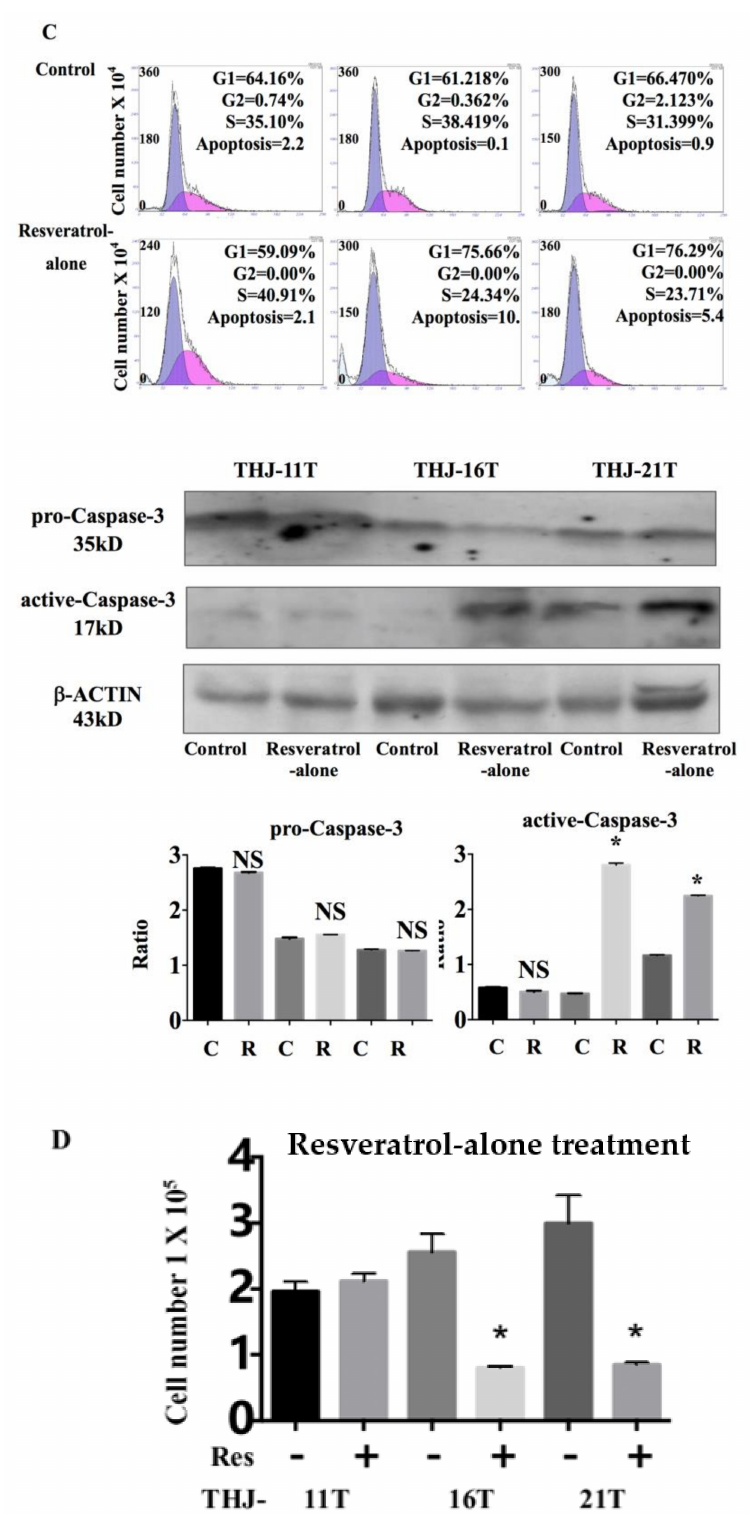
Figure 2. Different responses of the three ATC cell lines to resveratrol treatment. ( A ) H/E staining ( × 40) and Cyclin D1 immunocytochemical staining (insets; × 40) ( B ) MTT cell proliferation assay; ( C ) flow cytometry and Western blotting for pro-caspase-3 and active-caspase-3; ( D ) viable cell counting. *, with statistical significance ( p < 0.05); the error bars, the mean ± standard deviation. Control, without resveratrol treatment; Res, 100 µ M resveratrol treatment. NS, without statistical significance ( p > 0.05); , apoptosis peak; , G1 phase; , S phase; , G2